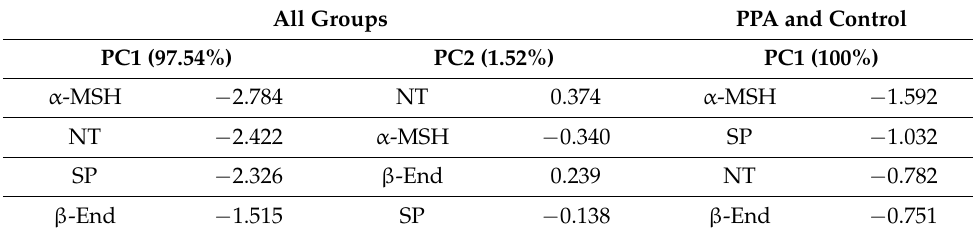
Table 2. Contribution of variables to PC1 and PC2 in discriminant analysis.